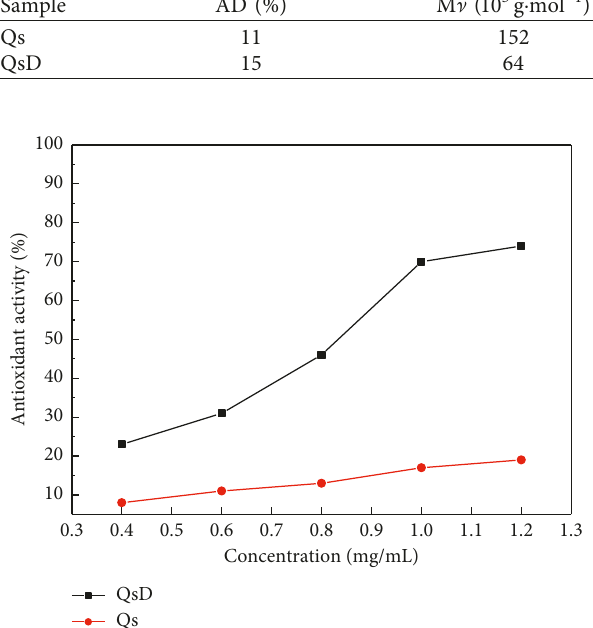
Figure 6: Antioxidant activity of Qs and QsD, which measures their capacity to trap the DPPH.